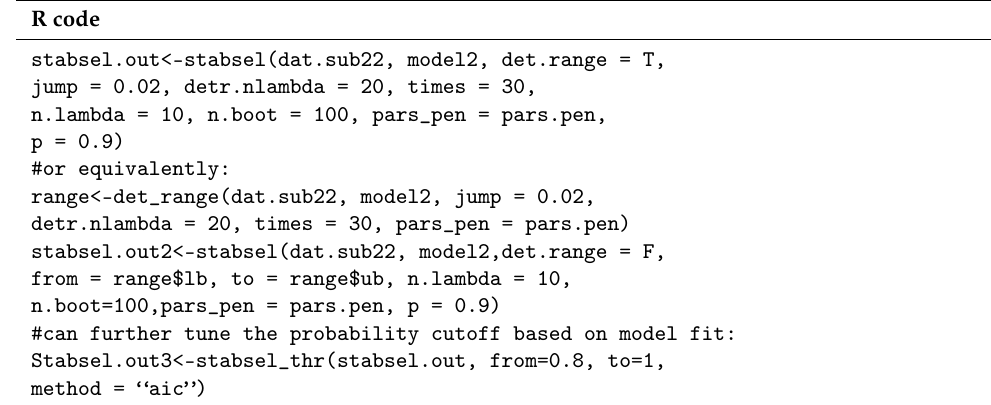
Table 6. R code stabsel() function for stability